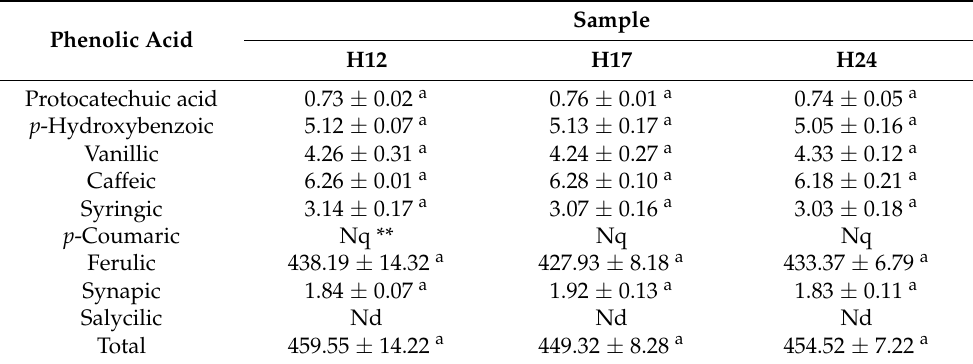
Table 7. Total phenolic acids profile (free and bound, µ g/mg d.m.) in OH. Phenolic